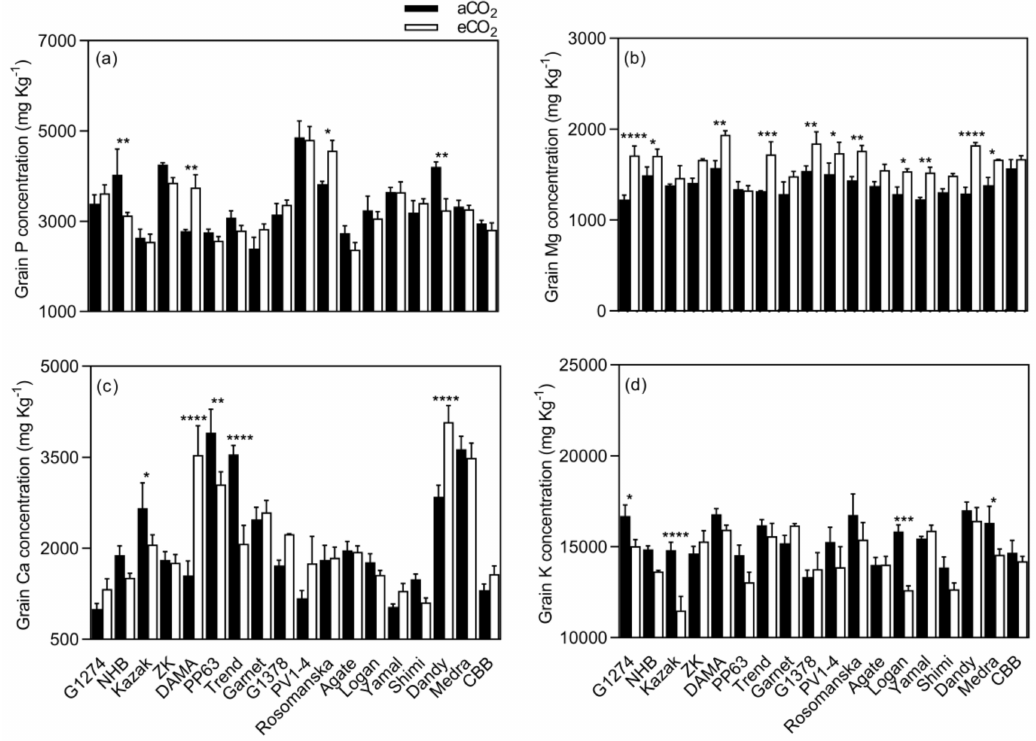
Figure 5. Grain macronutrient ( a – d ) concentrations of bean grown under aCO 2 (400 ppm) and eCO 2 (800 ppm). Each bar represents the mean ± SE ( n = 10 plants). * p < 0.05; ** p < 0.01; *** p < 0.001; **** p < 0.0001 significance level. Table 3. Significance levels of main e ff ects and interactions of CO 2 and varieties on bean grain